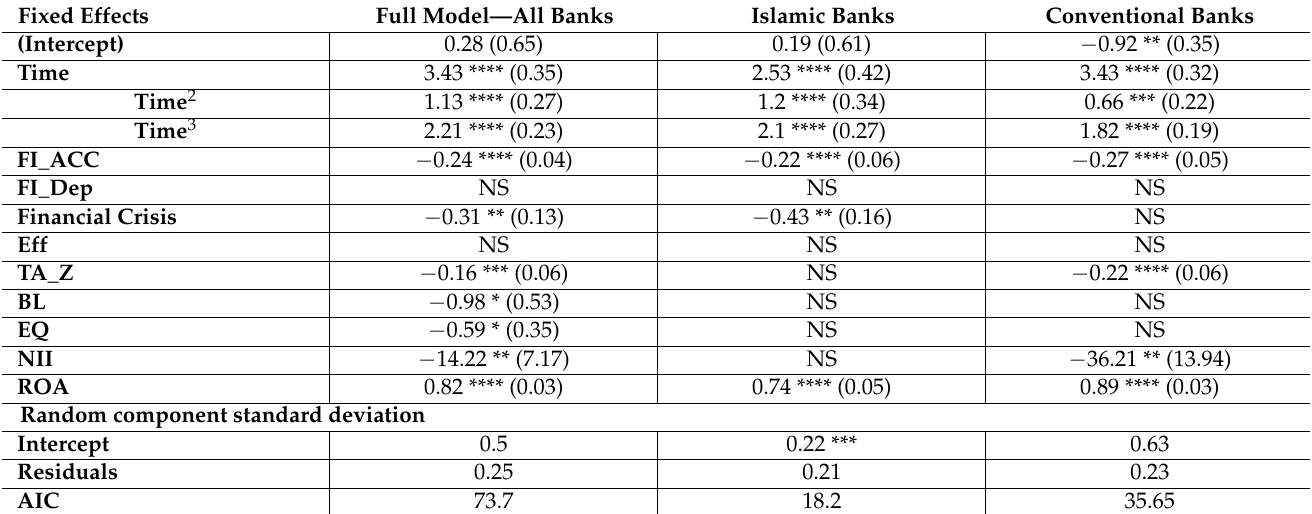
Table 7. Results of Linear Mixed Model for Islamic and conventional bank stability.